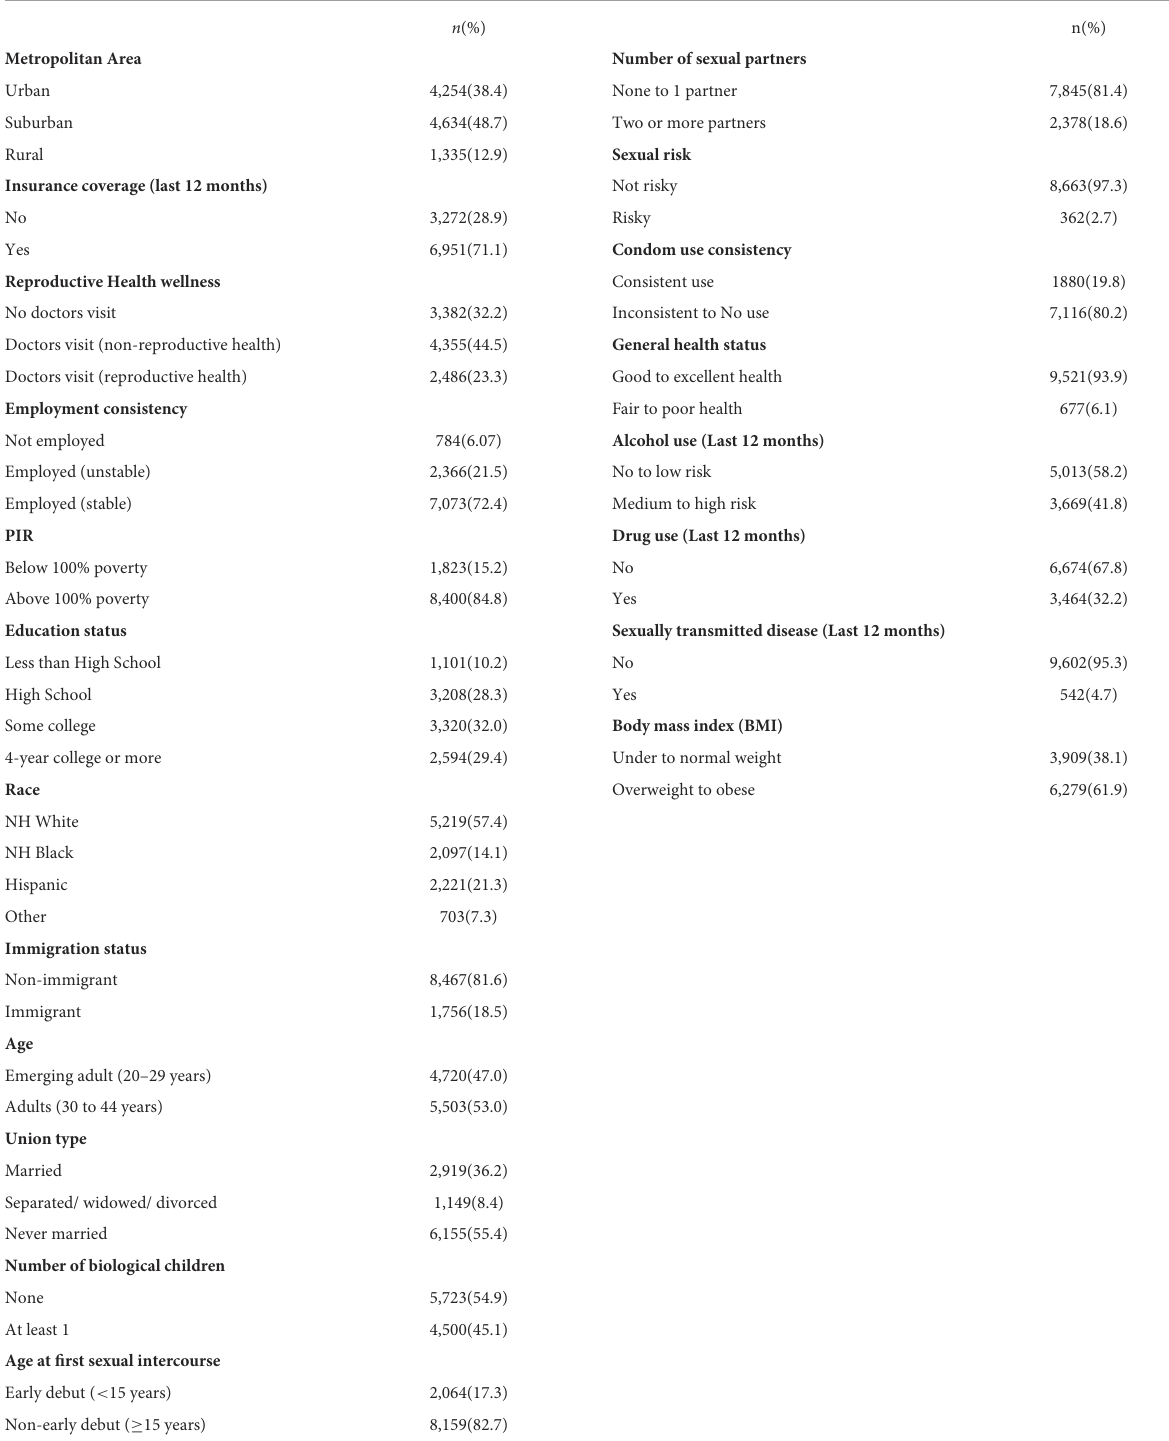
TABLE 1 Weighted descriptive statistics of National Survey of Family Growth male sample (2011–2019). SDOH and demographic variables 2011 to 2019 ( n = 10,223) Manifest